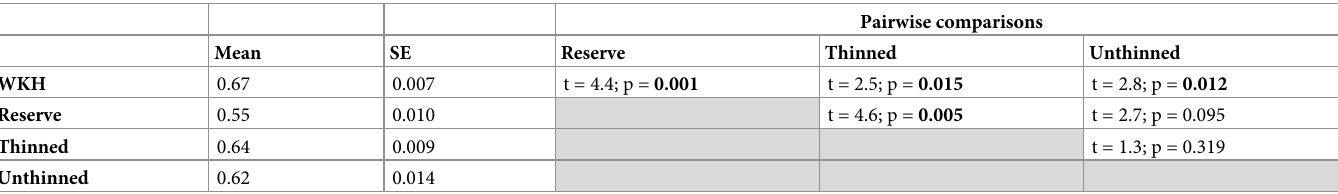
Table 5. Beta diversity. Multivariate dispersion (mean distances from centroid) for traps of each forest type with associated standard error (SE), from PERMDISP analysis based on modified Gower dissimilarity of saproxylic species abundance data. P-values below 0.05 in bold. WKH = Woodland Key Habitat.